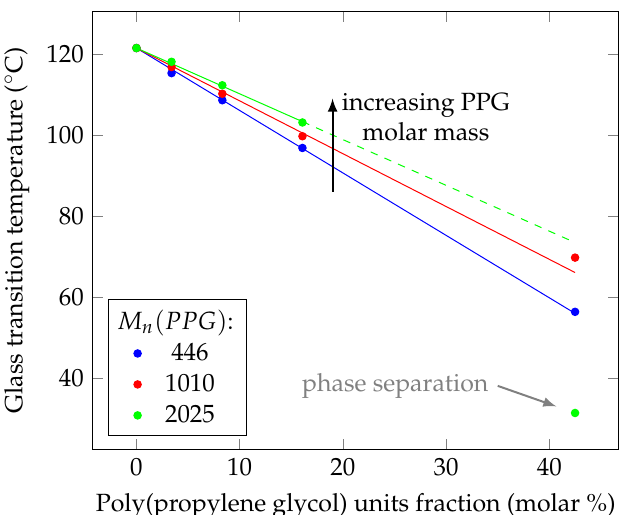
Figure 3. Effect of poly(propylene glycol) content on the glass transition temperature, measured with DMTA. Increasing molar fraction of PPG units in the polymer blend leads to linear decrease of the glass transition temperature. This effect weakens on the increase of PPG molar mass. The sample with 30 wt.% of PPG ( M n 2025), which exhibits loss of transparency, is deviating strongly from the extrapolated dependency, unlike similar samples with PPG of lower molar